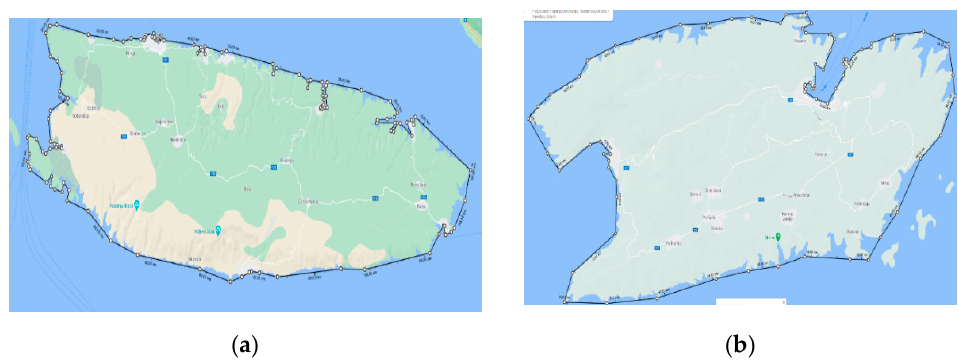
Figure 6. Coastline boundaries positions: ( a ) Island of Brac; ( b ) Island of Vis.